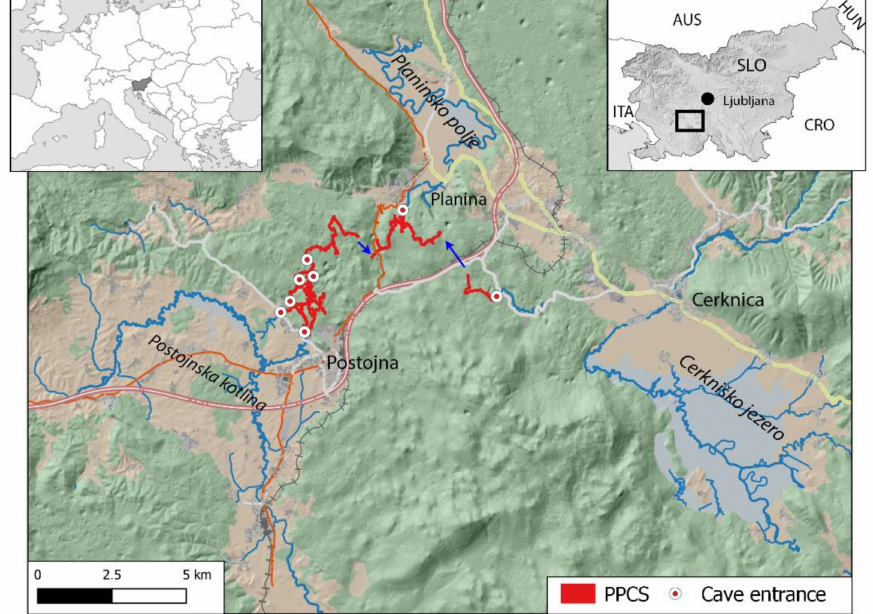
Figure 1. Location of the Postojna-Planina Cave System in central Slovenia. Top left: position of Slovenia within Europe; top right: position of PPCS within Slovenia; middle: red lines depict the planar views of all caves of the system; red dots: entrances to caves; blue arrows: parts of the system connected via subterranean rivers, but not yet passed by